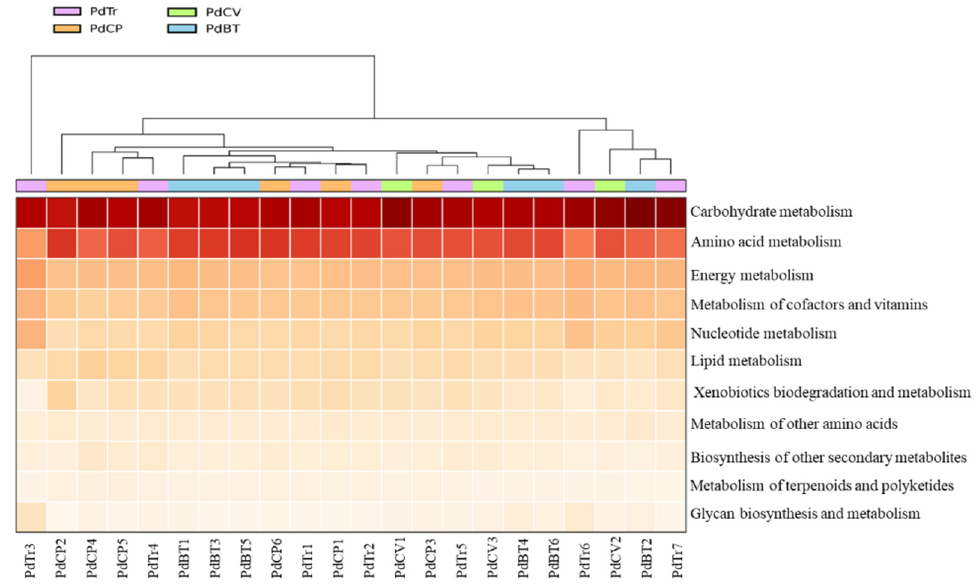
Figure 6. Heatmap of KEGG pathways relative abundance, per sample, associated with “metabolism” functional module predicted in Porcellio dilatatus bacterial communities. P. dilatatus guts were sampled from Tronco (PdTr) (purple); Corte-Pinto (PdCP) (orange); Cabeço-de-Vide (PdCV) (green), and Botanical Garden of University of Coimbra (PdBT) (blue).